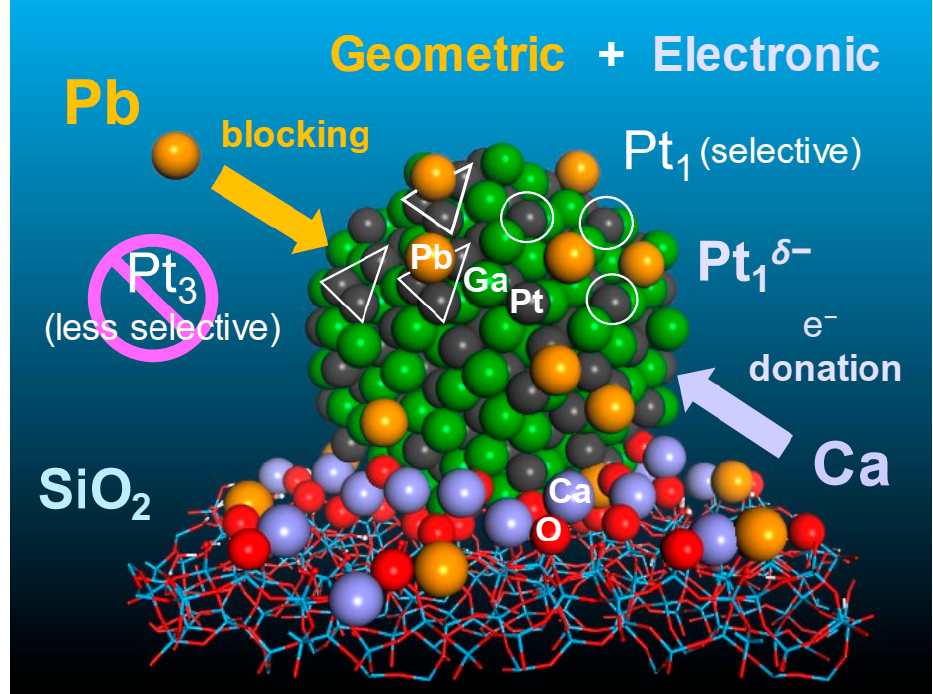
Figure 4 . Catalyst design concept for the double decoration of the nanoparticulate intermetallic PtGa-CaPb/SiO 2 . Reprinted with permission from ref. [52]. Copyright 2021 Wiley-VCH GmbH.